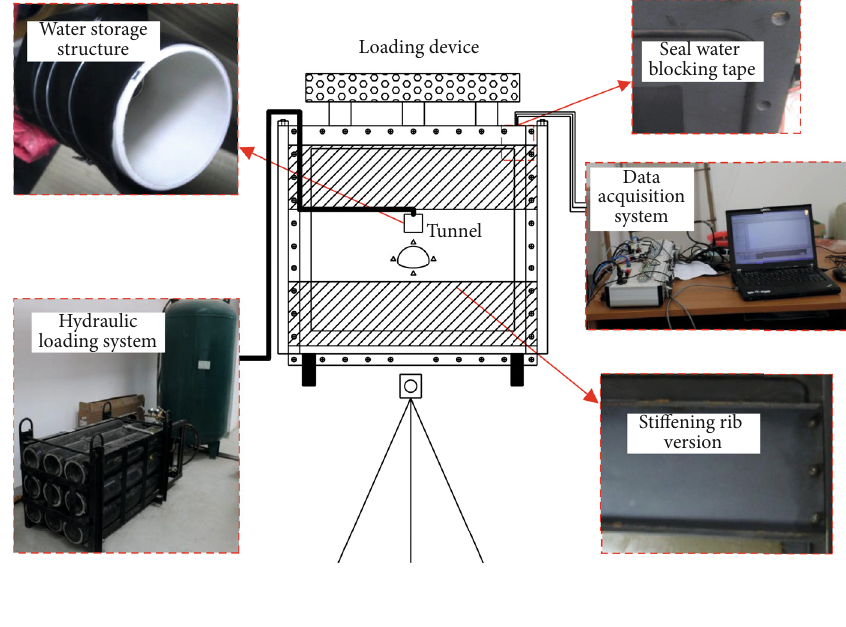
Figure 2: Experimental system of water inrush disasters for the karst tunnel.